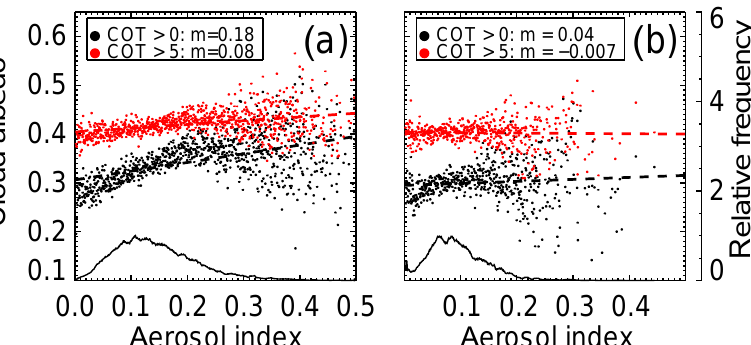
Figure 5. Binned cloud albedo as a function of aerosol index based on high-resolution aerosols that are paired to (a) the nearest cloud observation (CAPA-L2 method) and (b) the nearest cloud observation that is at least 15km away (CAPA-L2_15km method) over JJA 2008. Cases are binned by 0.001-wide bins in AI over the California region (20–30 ◦ N, 140–130 ◦ W). The relative frequency of occurrence in AI is also provided in the plot. Both methods are composited further by selecting cloud retrievals with cloud optical thickness (COT) greater than 5 (red points). Least squares fit line and value of the slope are provided for each composite.